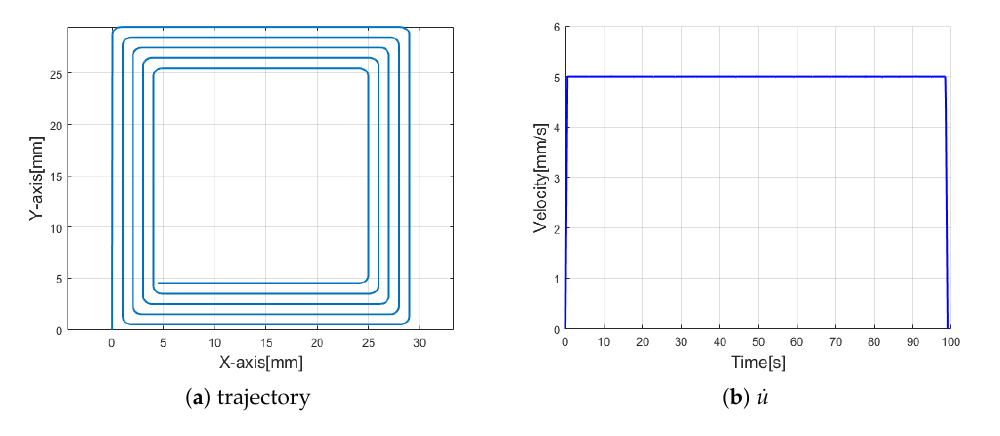
Figure 15. Actual